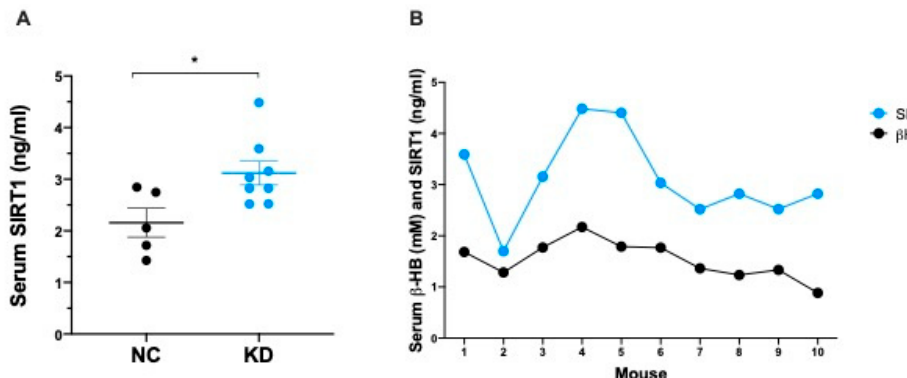
Figure 3. ( A ) Dot plot showing SIRT1 concentration (ng/mL) in serum from mice under NC (n = 5) and KD (n = 8) at the end of dietary treatment. Data are expressed as mean ± SEM. * p < 0.05. ( B ) Pearson correlation analysis between serum β HB and SIRT1 levels in mice under KD (n = 10). r = 0.732, p = 0.0156.